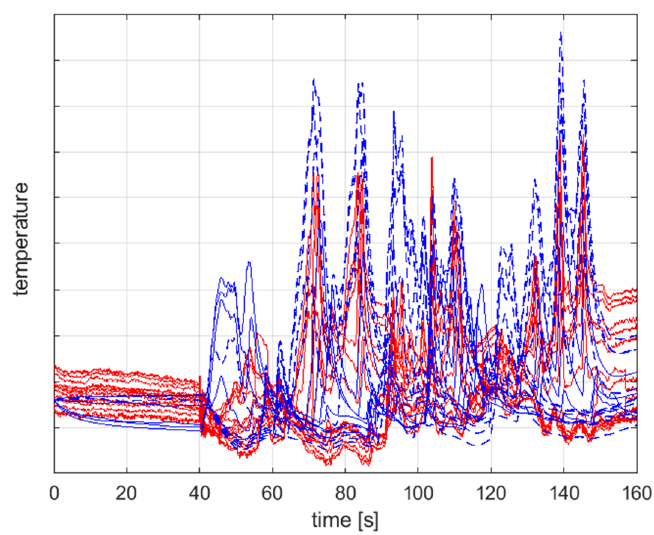
Figure 5. Comparison between the tread external temperatures obtained by means of the 16-ribs’ configuration model (in blue) and the acquired ones (in red).